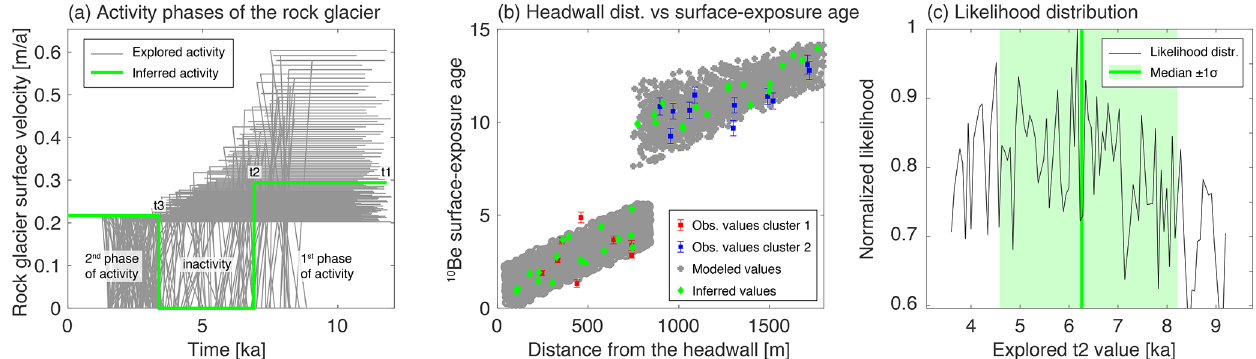
Figure 11. (a) Activity phases of the rock glacier, defined as the evolution of the rock glacier surface velocity in time (explored histories and the best-fitting history are shown as grey and green lines, respectively). (b) Relationship between 10 Be surface-exposure age and distance to the headwall. Observed values of the clusters 1 and 2 are shown as red and blue squares, respectively. Modeled and best-fit values are shown in grey and green, respectively. (c) Likelihood distribution of the inversion exploring the time at which the first phase of activity ends (t2). See Sect. 5.3 for